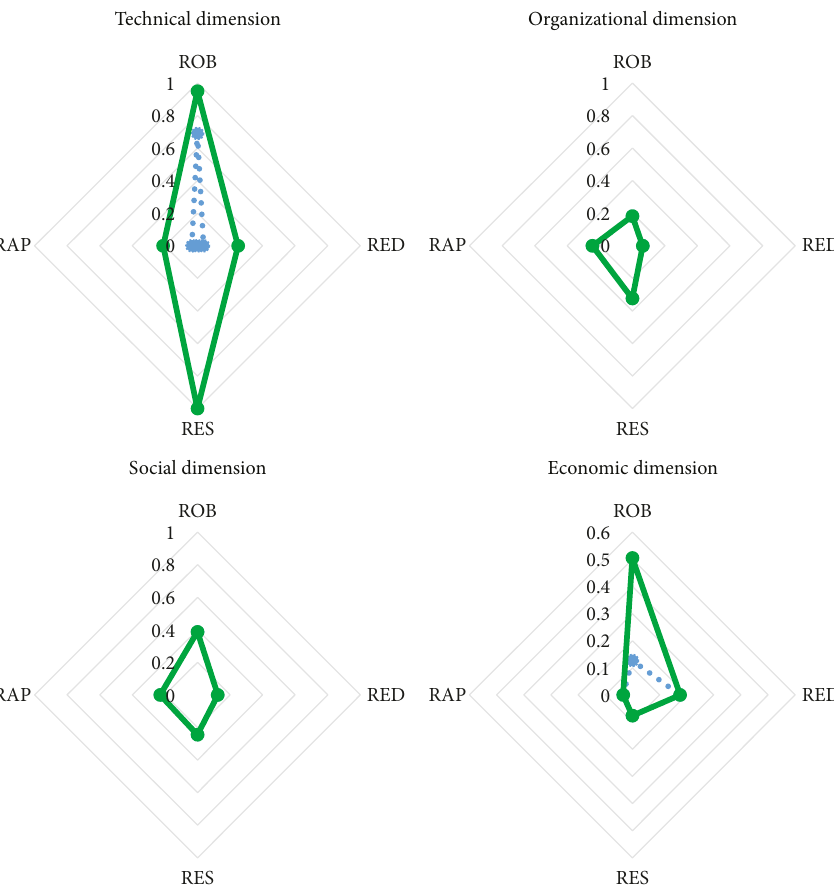
Figure 4: Spider graph showing the values of speci fi c components of resilience according to the metrics de fi ned in Table 12, referring to scenario